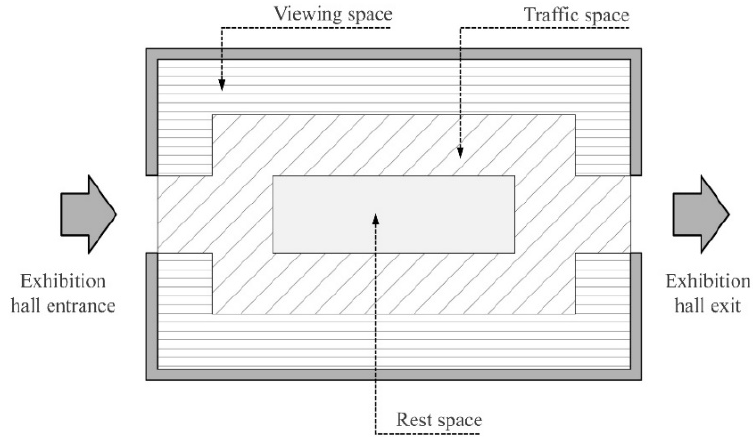
Figure 11. Typical exhibition space allocation in the museum of art.